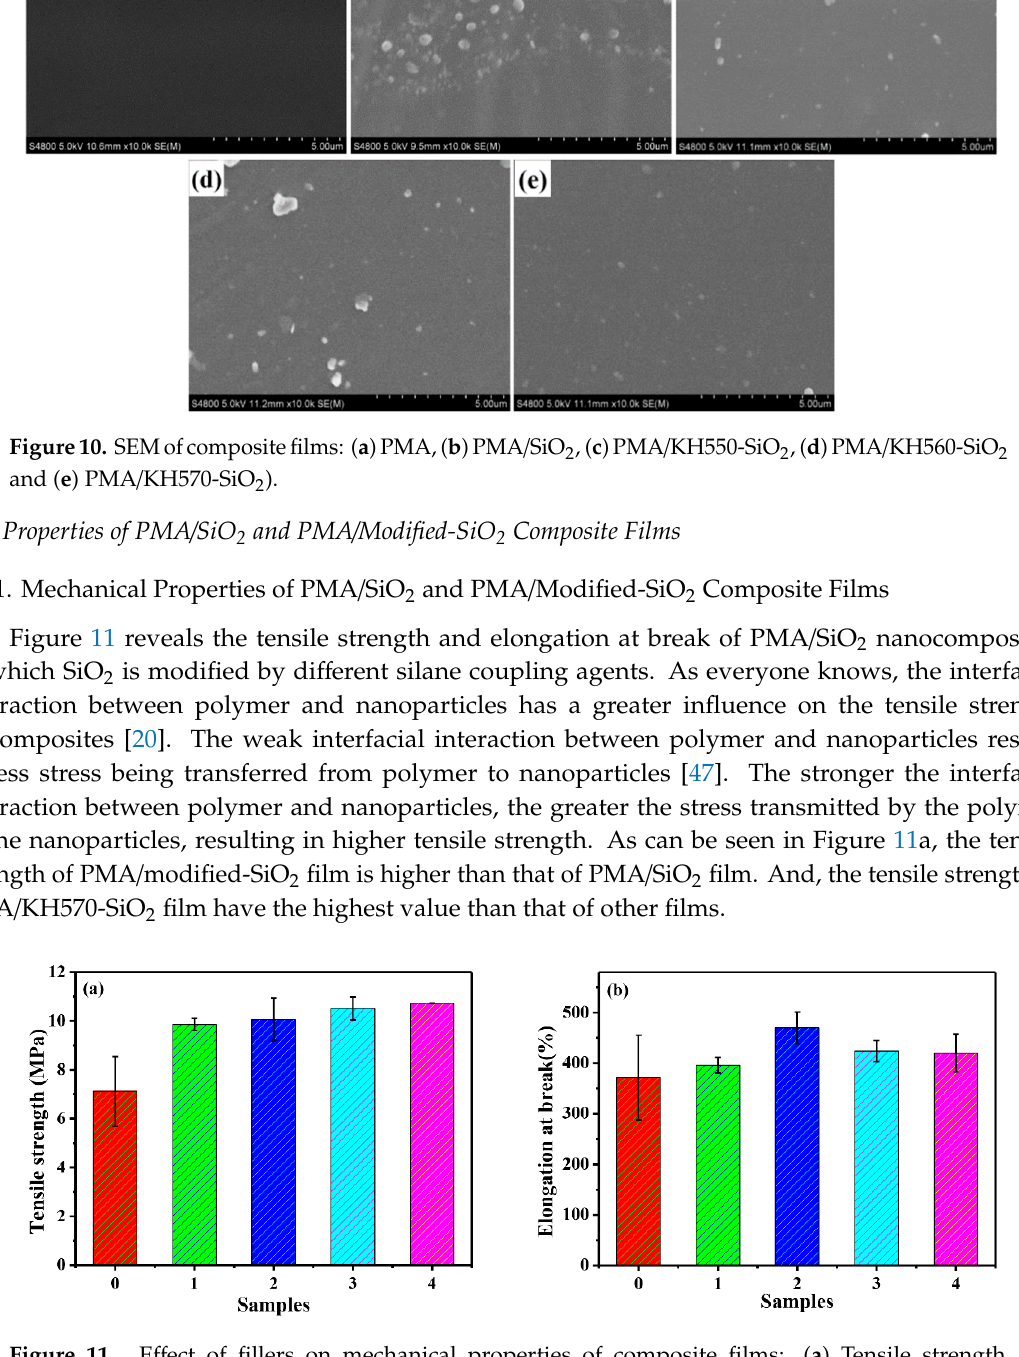
Figure 11. Effect of fillers on mechanical properties of composite films: ( a ) Tensile strength, ( b ) Elongation at break ( 0. PMA, 1. PMA/SiO 2 , 2. PMA/KH550-SiO 2 , 3. PMA/KH560-SiO 2 and 4. PMA/KH570-SiO 2 ).